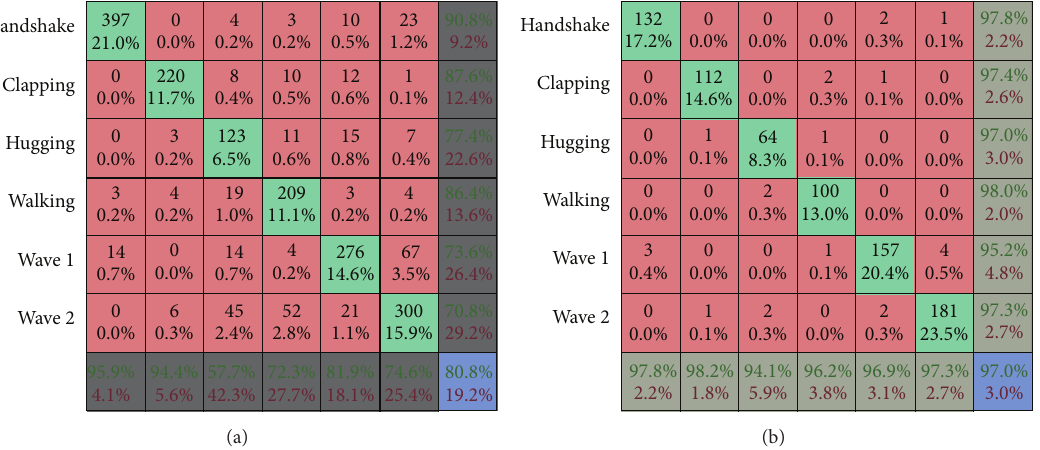
0102030405060708090100